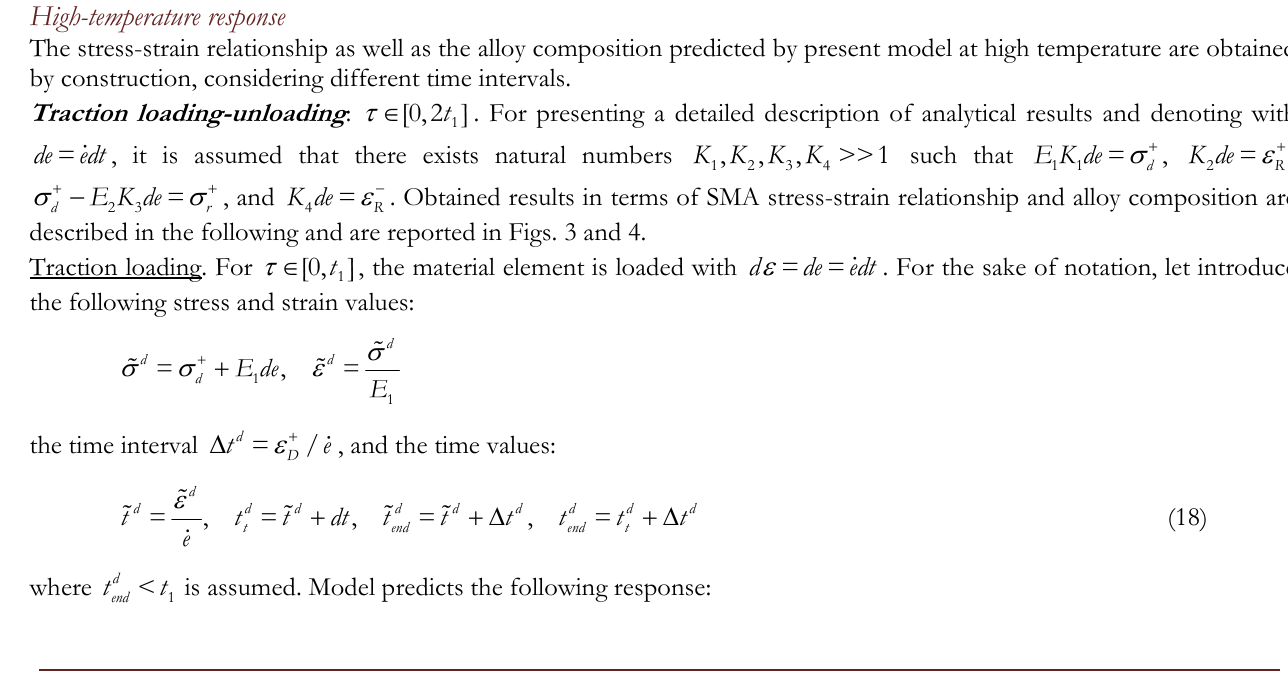
Figure 4: Alloy composition predicted by present model for a traction loading-unloading test obtained from applied strain in Fig. 2  (resp.,  ) vs.  at the high temperature [0,2 ] t  . (a) In black, for 1 1 4 Evolution of alloy composition in the space of the admissible volume fractions at high and low temperature (dimensions of arrows are not in